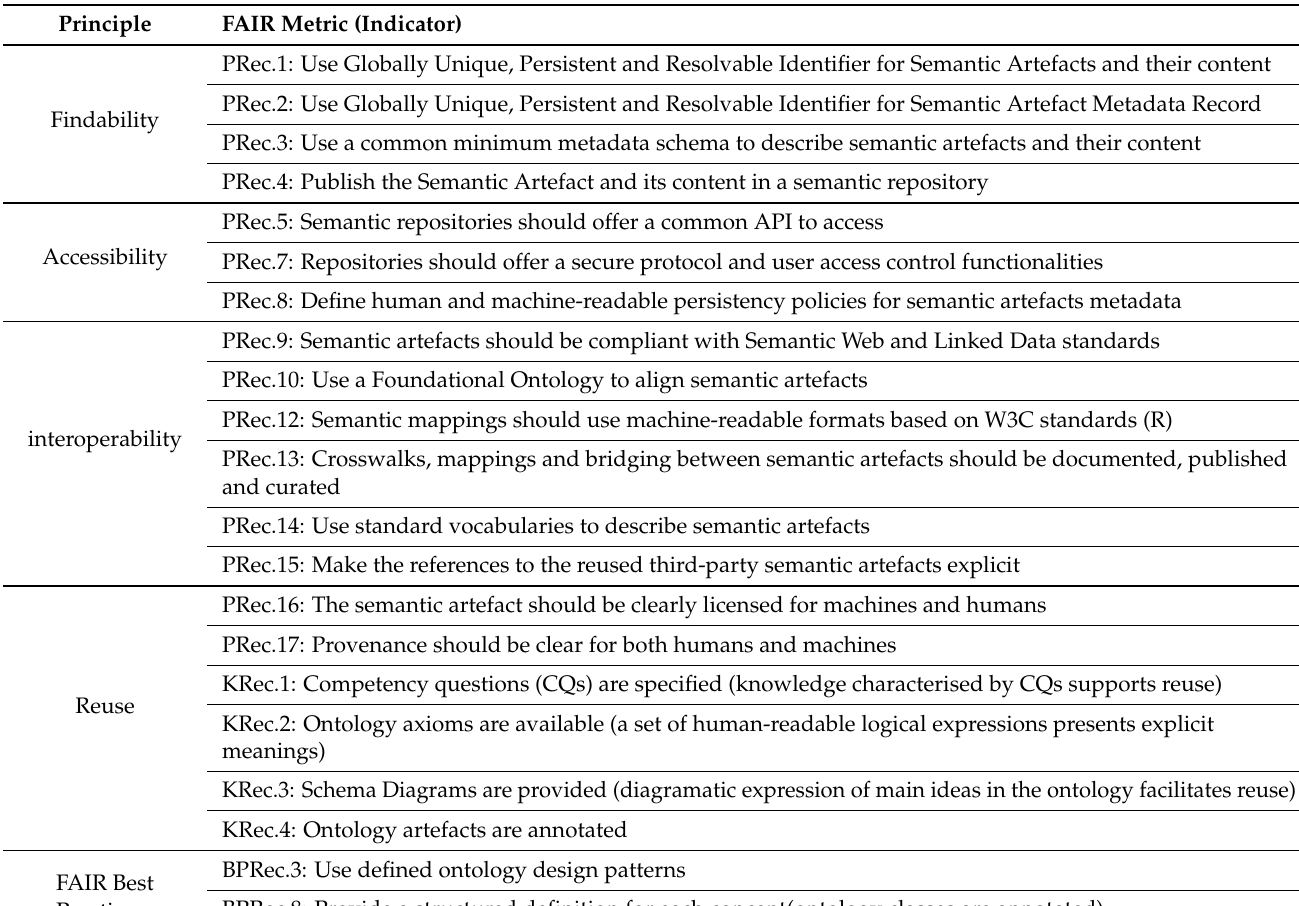
Table 2. FAIR Metrics for Ontologies, Adapted from [17,25].